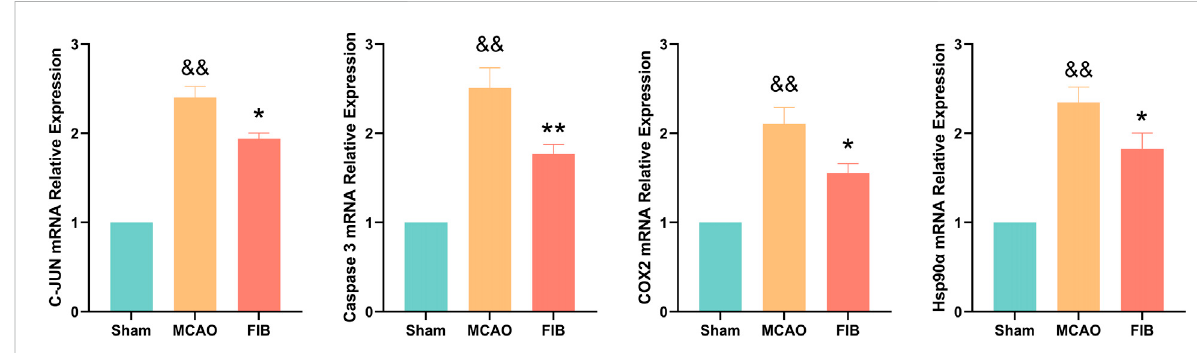
FIGURE 10 The effect of FIB on the expression levels of Caspase3, HSP90AA1, C-JUN and COX2 in MCAO mice was detected by PCR. && p < 0.01, vs. the sham group. * p < 0.05, ** p < 0.01, vs. the MCAO group ( n = 3).